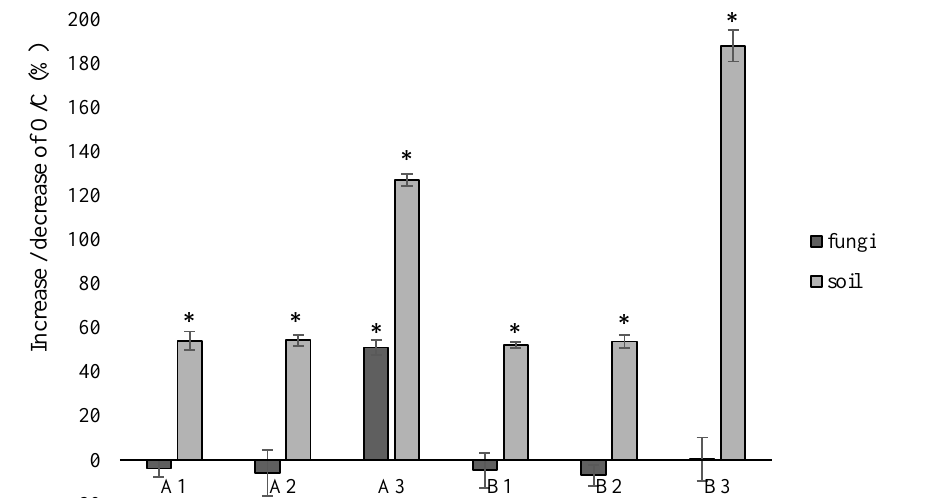
Figure 5. O/C ratio after incubation of the samples with fungi or in the soil solution in relation to the control samples. *—statistically significant difference based on the one-way ANOVA analysis.